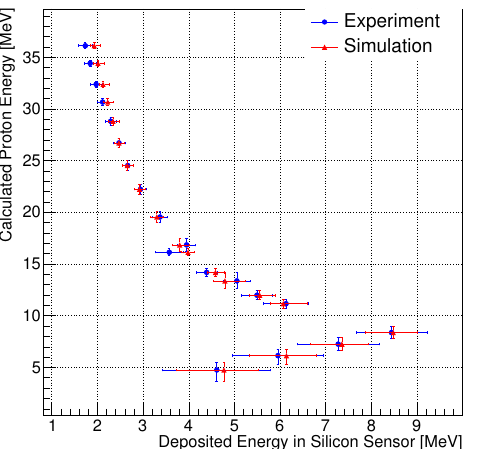
Figure 12. Relationship Between Deposited Energy in the Silicon Detector and Expected Energy According to Monte Carlo